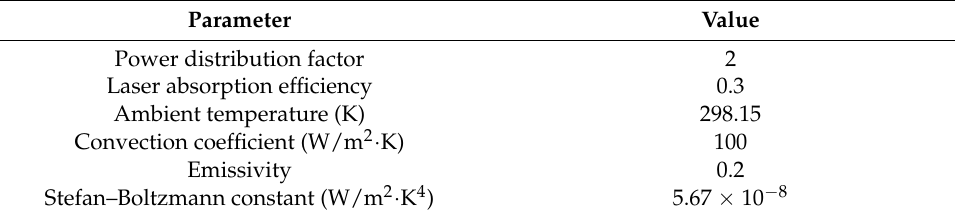
Table 3. Parameters applied in the